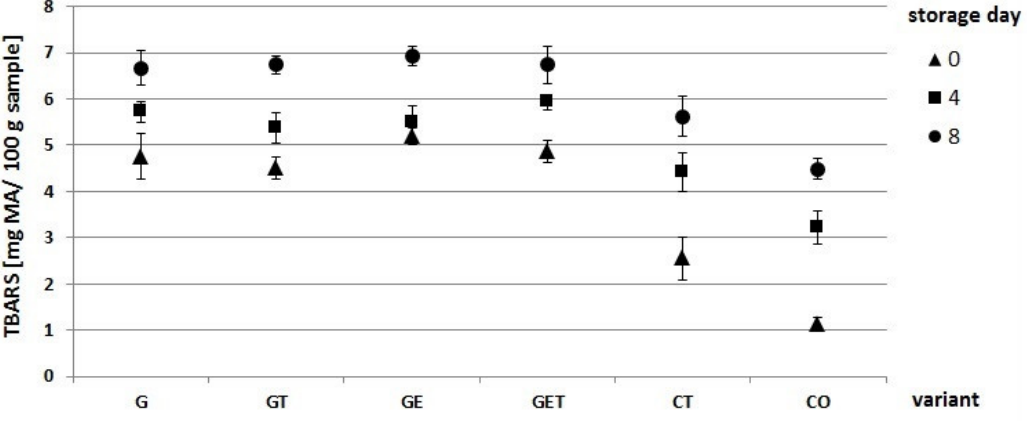
Figure 3. Analysis of lipid oxidation (TBARS) in burgers with a fat substitute after 0, 4, and 8 days of storage. G—encapsulated oil; GT—encapsulated oil + tallow; GE—encapsulated oil with açai extract; GET—encapsulated oil with açai extract + tallow; CT—control with tallow; CO—control with